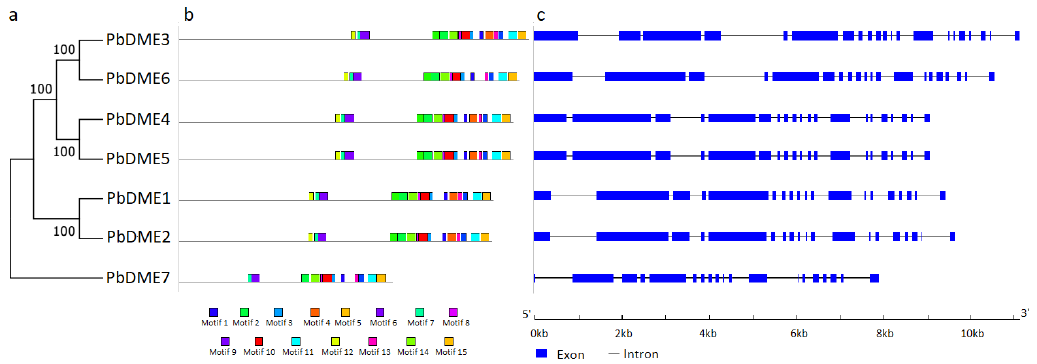
Figure 1. Phylogenetic and structural analysis of the PbDME family in pear ( Pyrus bretschneideri ). Phylogenetic tree of the PbDME family in pear was generated using the neighbor-joining with 1000 bootstraps in MEGA 7 [60]. Motif analysis was with MEME software [57], and gene structure was analyzed using GSDS 2.0 [58].